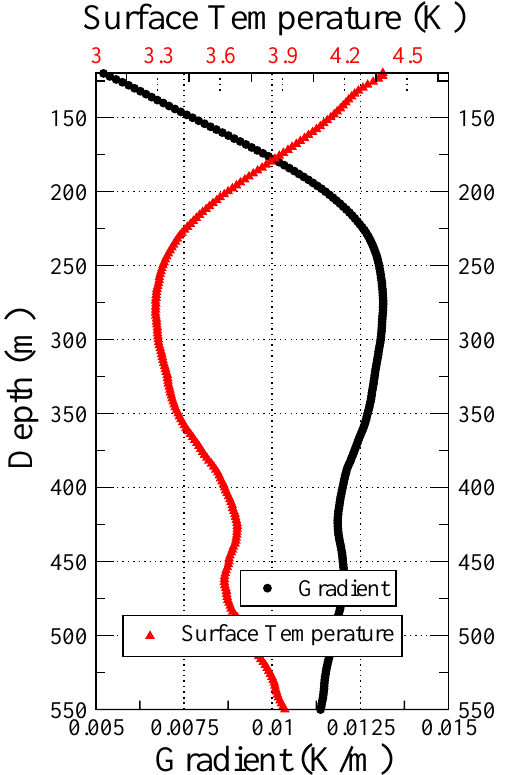
Fig. 10. Changes in the estimated equilibrium surface temperature, T 0 , and geothermal gradient, 0 0 , as a function of depth for the tem- perature data measured at Minchin Lake borehole. High frequency noise due to the variability of the thermal properties is apparent. The mean value of the thermal conductivity is 3Wm − 1 K − 1 (IHFC, 2011). Note that the true equilibrium surface temperature and geothermal gradient are unknown in the observational